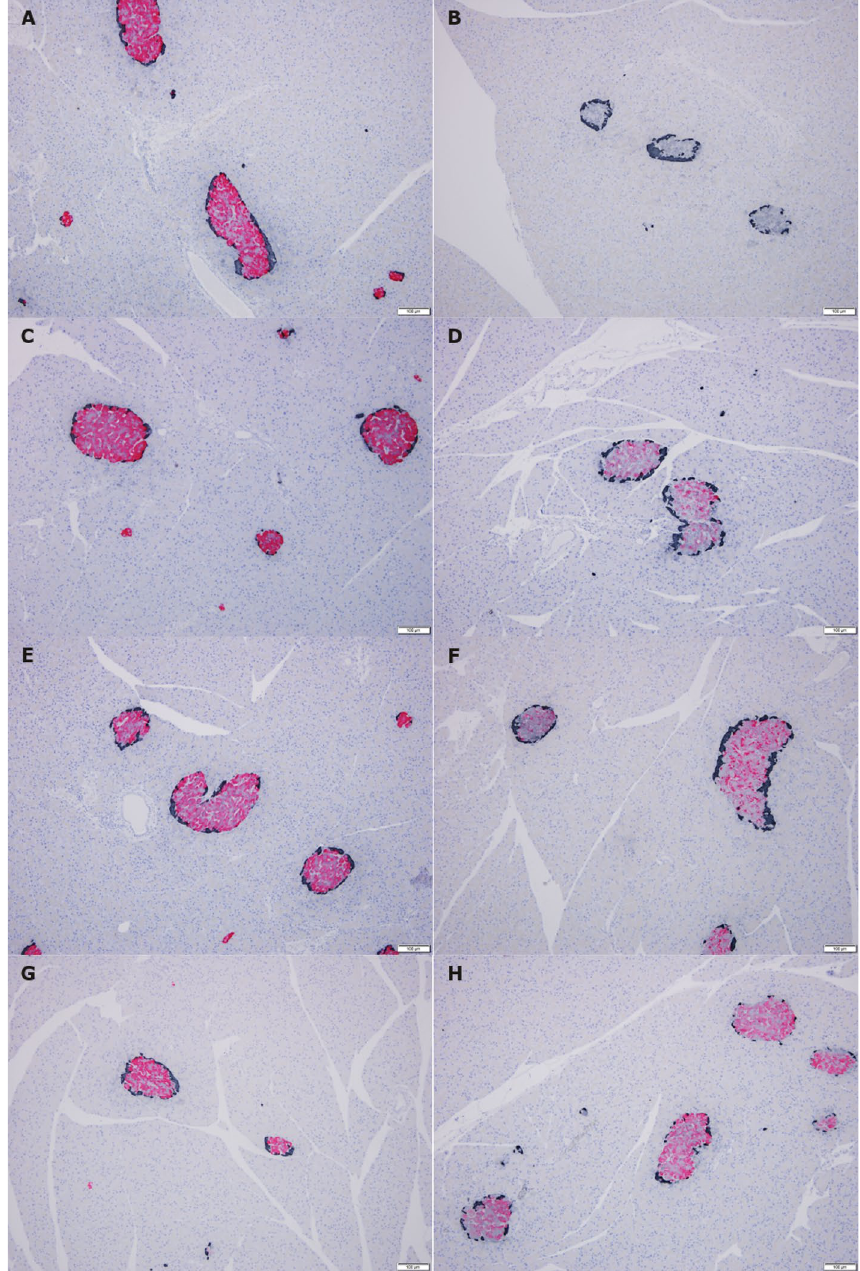
Figure 3. Microscopic images of pancreatic tissue double-stained for insulin (pink) and glucagon (black). Representative examples. Left panel: Controls, right panel: HI-infused animals. ( A ) + ( B ): Week 4, ( B ) is an example of islets completely negative for insulin staining. ( C ) + ( D ): Week 8, for some of the islets in the HI-infused animals insulin staining was completely absent. ( E ) + ( F ): Day 2R, ( G ) +( H ): Week 4R. R, recovery (infusion-free period). Magnification: × 100, scalebar: 100